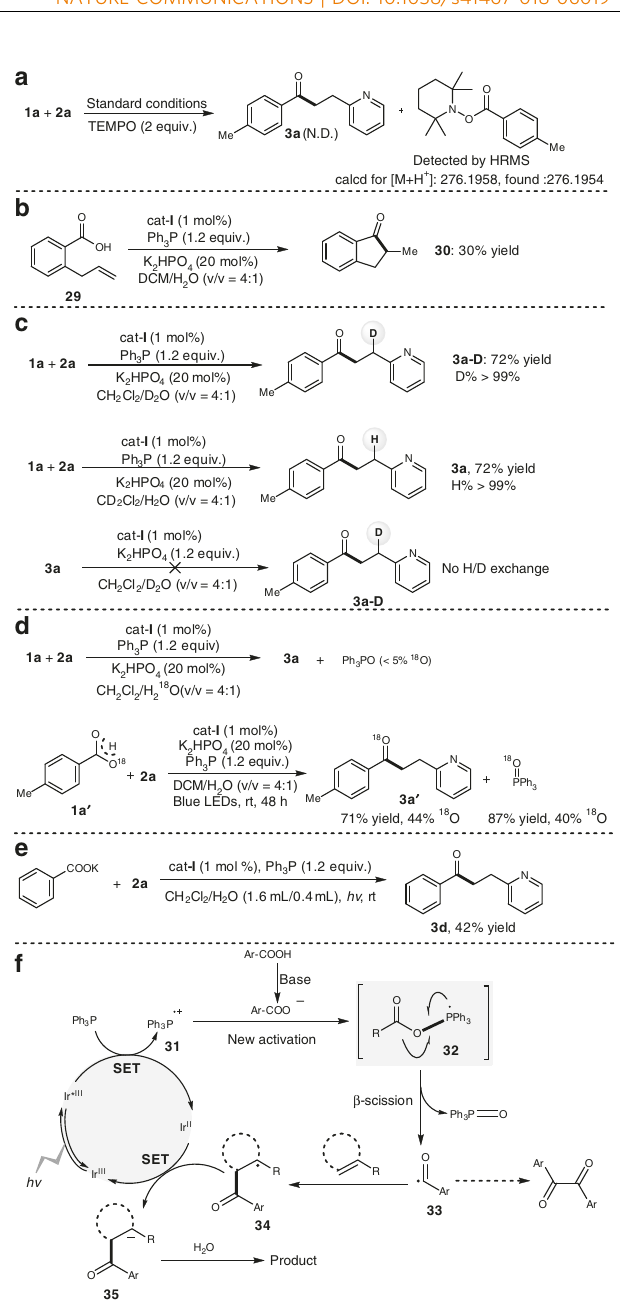
Fig. 8 Mechanistic studies. a Control experiments with additives. b Radical cyclization experiment. c Deuterium-labeling experiments. d 18 O-labeling experiments. e Aromatic carboxylate anion as substrate. f Proposed